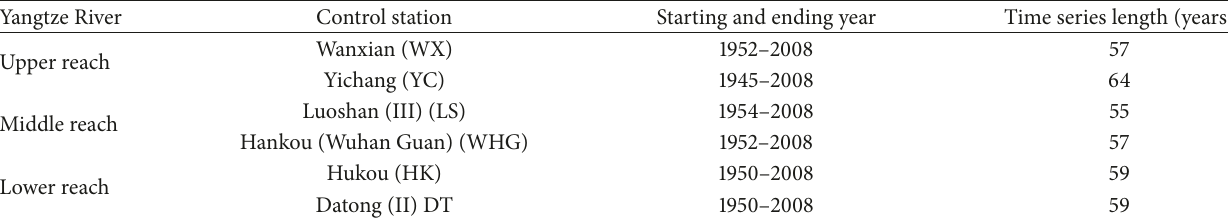
Table 1: Data series of measured runoff in the Yangtze